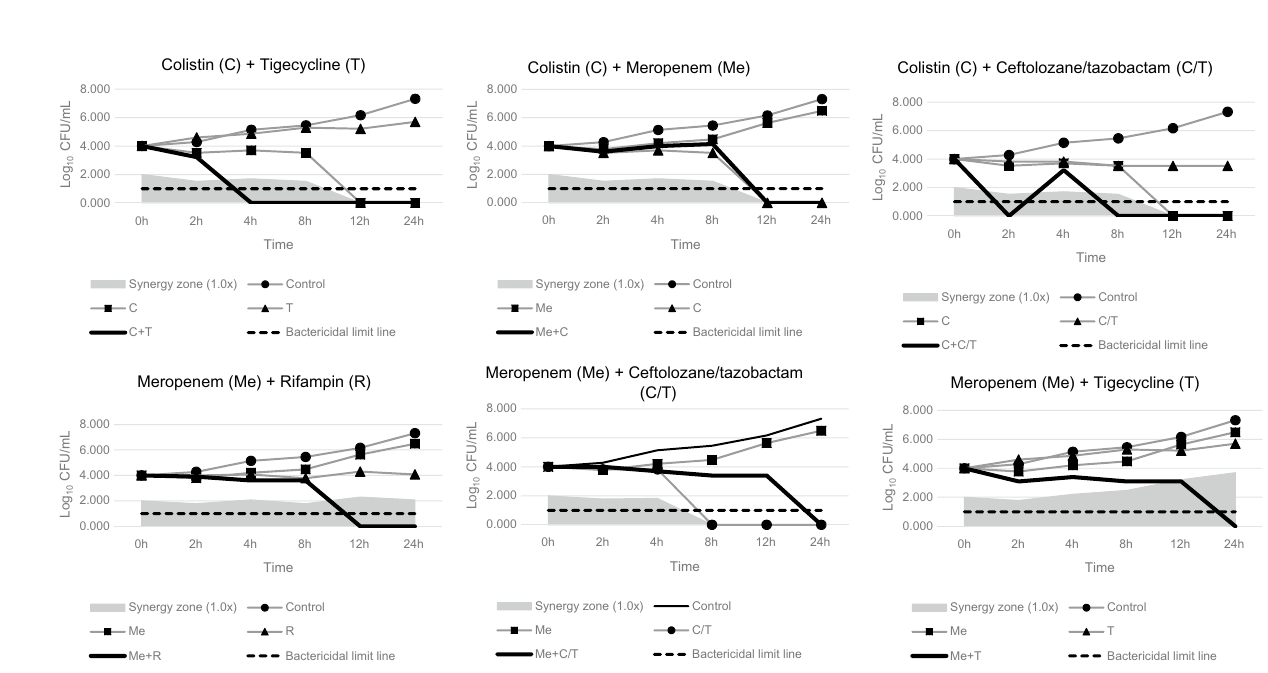
Figure 1. Time-kill curves of Acinetobacter baumannii isolates (CRAB 34) at 1 × minimum inhibitory concentration (MIC) for six combinations of